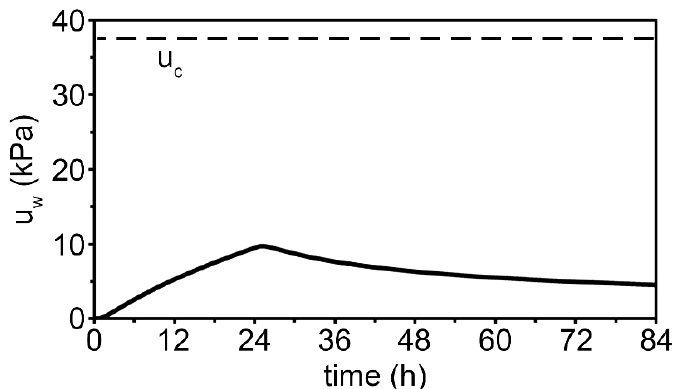
Figure 14. Evolution of the change in pore water pressure, w u , with time due to the rainfall of 10 April 2005, with indication of the critical threshold, c u , at the depth of 0.80 m.